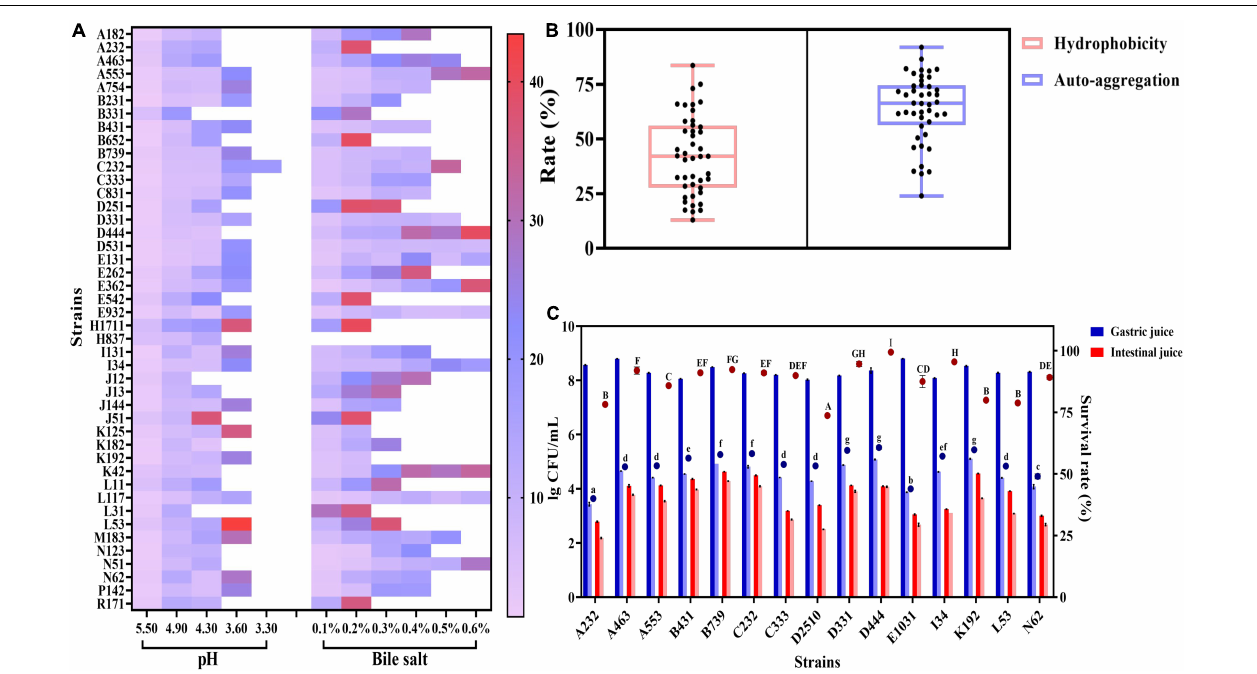
FIGURE 1 | Adaptation of L. plantarum strains to the gastrointestinal environment: (A) lag phase of strains growth in different concentrations of acid and bile salt environments; (B) adhesion ability of strains by hydrophobicity (light pink box plot) and auto-aggregation index (light blue box plot); (C) survival of strains in simulated gastric juice and simulated small intestinal juice. The bar charts show the viable cell number of the strains at 0 and 3 h and the dots indicate the survival rates of strains. The letters a–g and A–I indicate statistically significant differences ( p < 0.05) within each dot.